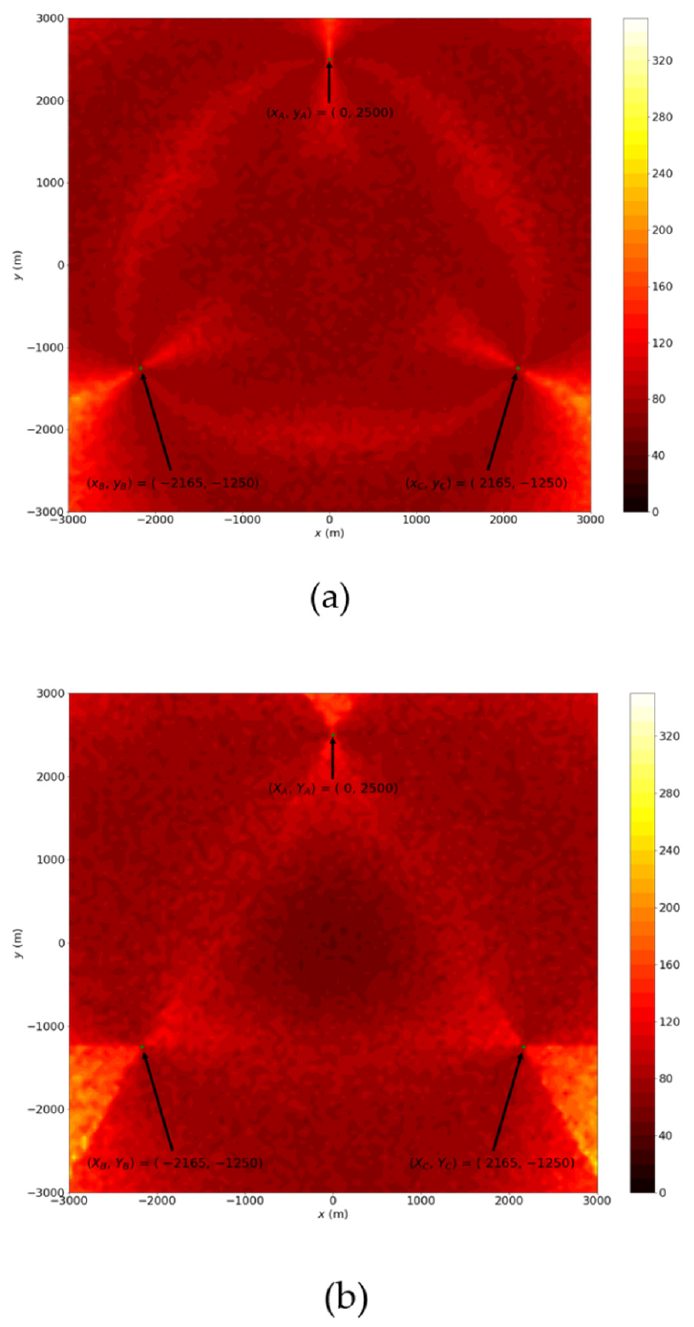
Figure 6. Simulated estimation error ( a ) without weighting; ( b ) with weighting. Hence, ˆ P T , AB , ˆ P T , AC and ˆ P T , BC should be considered together to make the error distri- bution smoother. Since each prediction result has its own probability, the final estimation result, ˆ P T , final , can be a weighted average location of the points ˆ P T , AB , ˆ P T , AC and ˆ P T , BC . Thus, the ˆ P T , final can be computed by Equation (16):